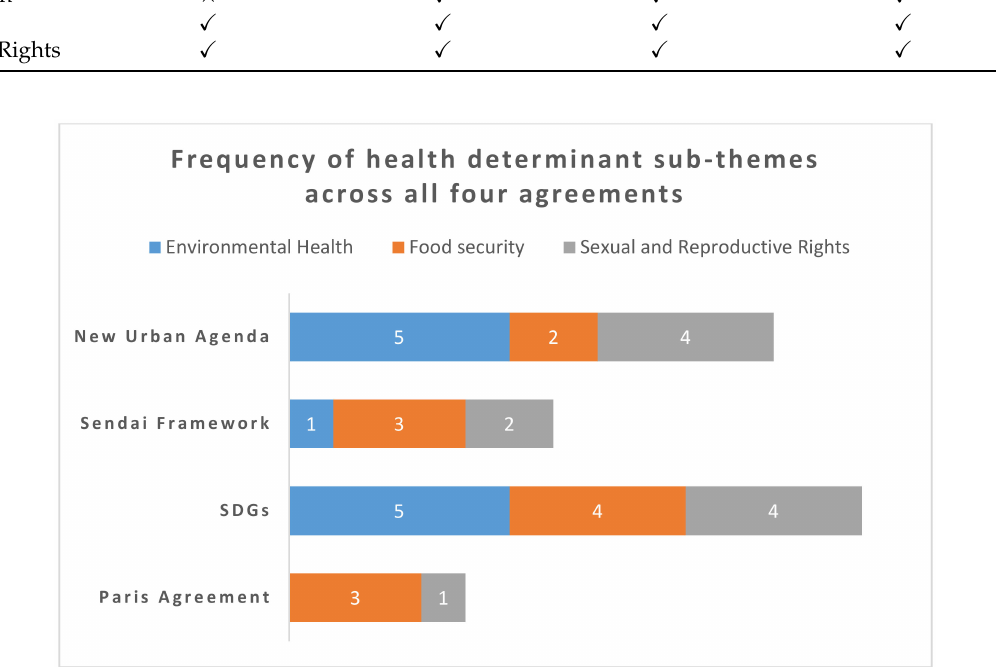
Figure 1. Overview of health determinant analysis across all four policy